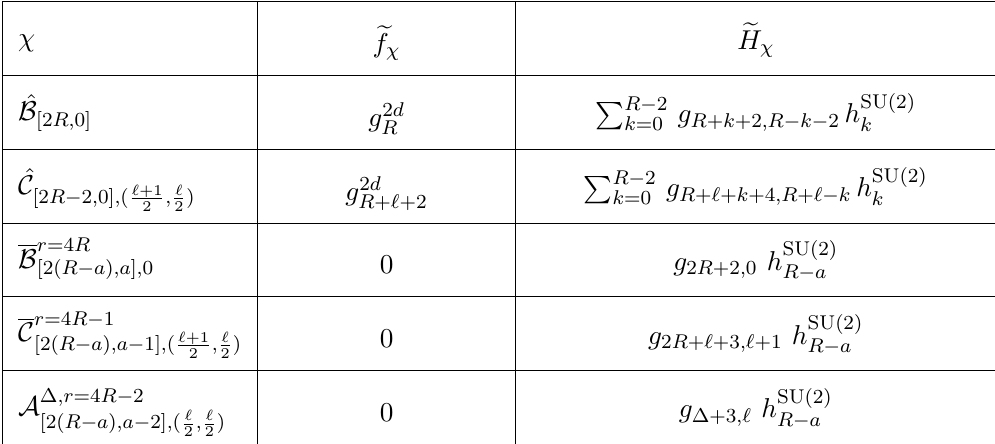
Table 3 . Superconformal blocks contributing to (3.22) in the parametrization (3.17), with f and H replaced by e f and e H to indicate they correspond to the chiral channel blocks. These expressions are consistent with the decompositions of superblocks at unitarity bounds, see (3.37). We recall